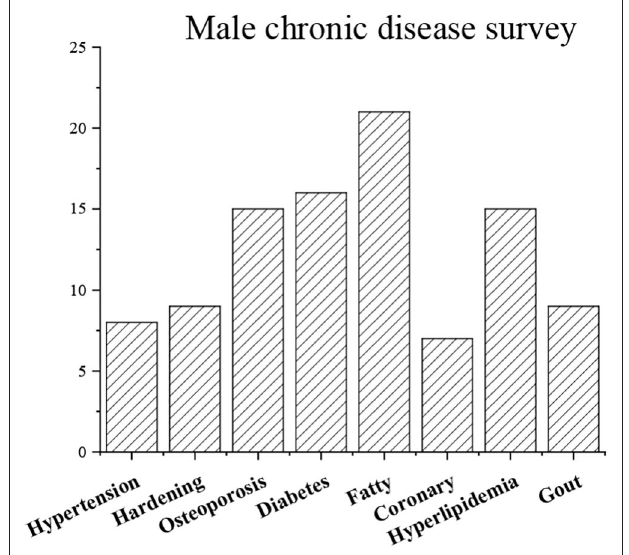
FIGURE 18 | General situation of residents’ chronic diseases (man).